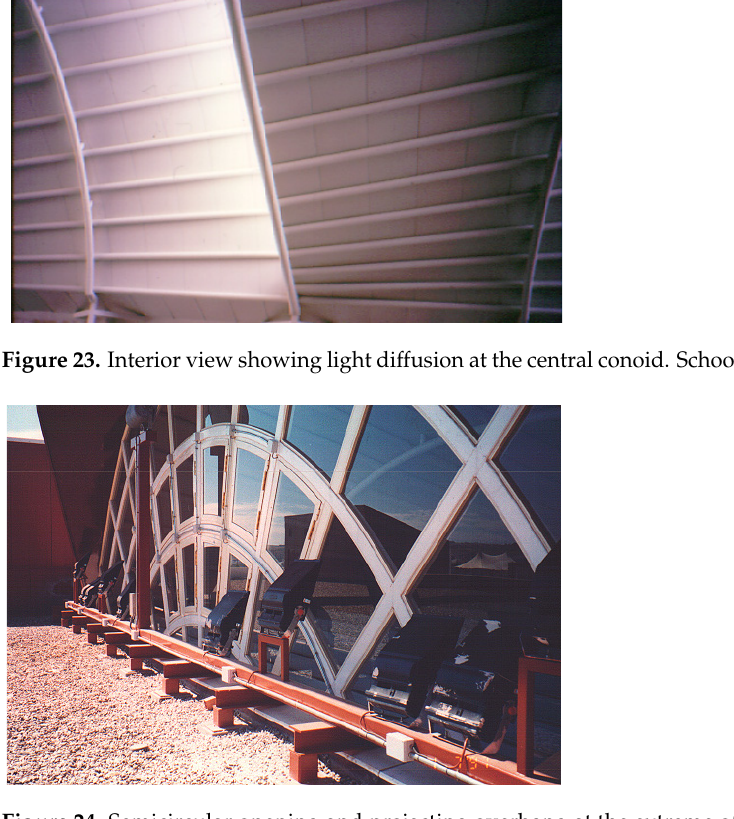
Figure 24. Semicircular opening and projecting overhang at the extreme of the central conoid of the School of Engineering of